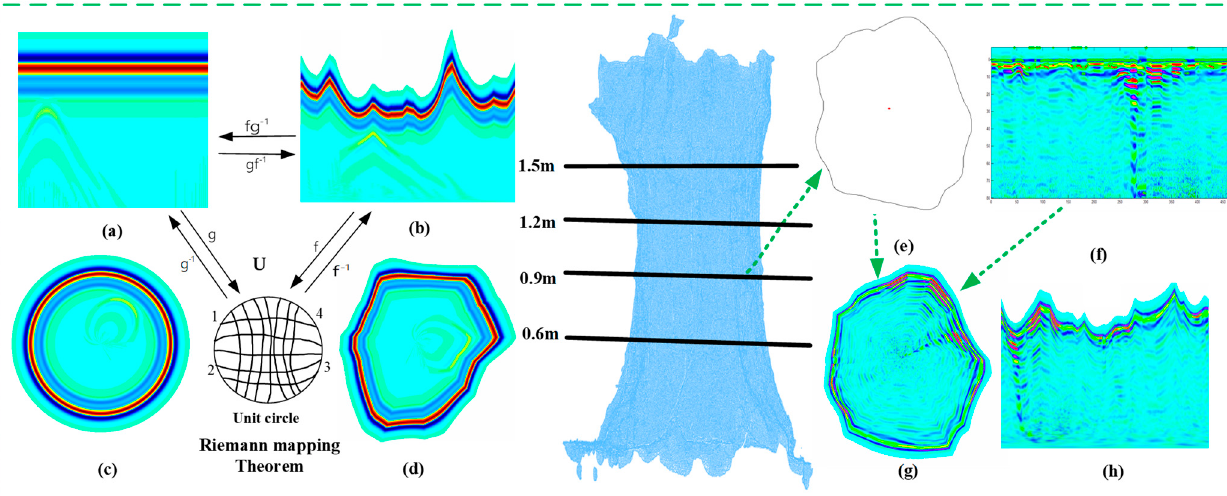
Figure 4. Radar detection of irregular tree trunks. On the left side of the trunk is a simulation based on the Riemann mapping theorem. ( a ) Numerical simulation of 2D targets in the normative domain; ( b ) numerical simulation of the 2D targets in the physical domain; ( c ) simulation results of the targets in the circular domain; ( d ) simulation results of the target under the irregular boundary. On the right side of the trunk is a simulation of the image affine technique: ( e ) outer contour at 0.9 m; ( f ) radar data at 0.9 m; ( g ) irregular radar image at 0.9 m; ( h ) physical domain radar image at 0.9 m.